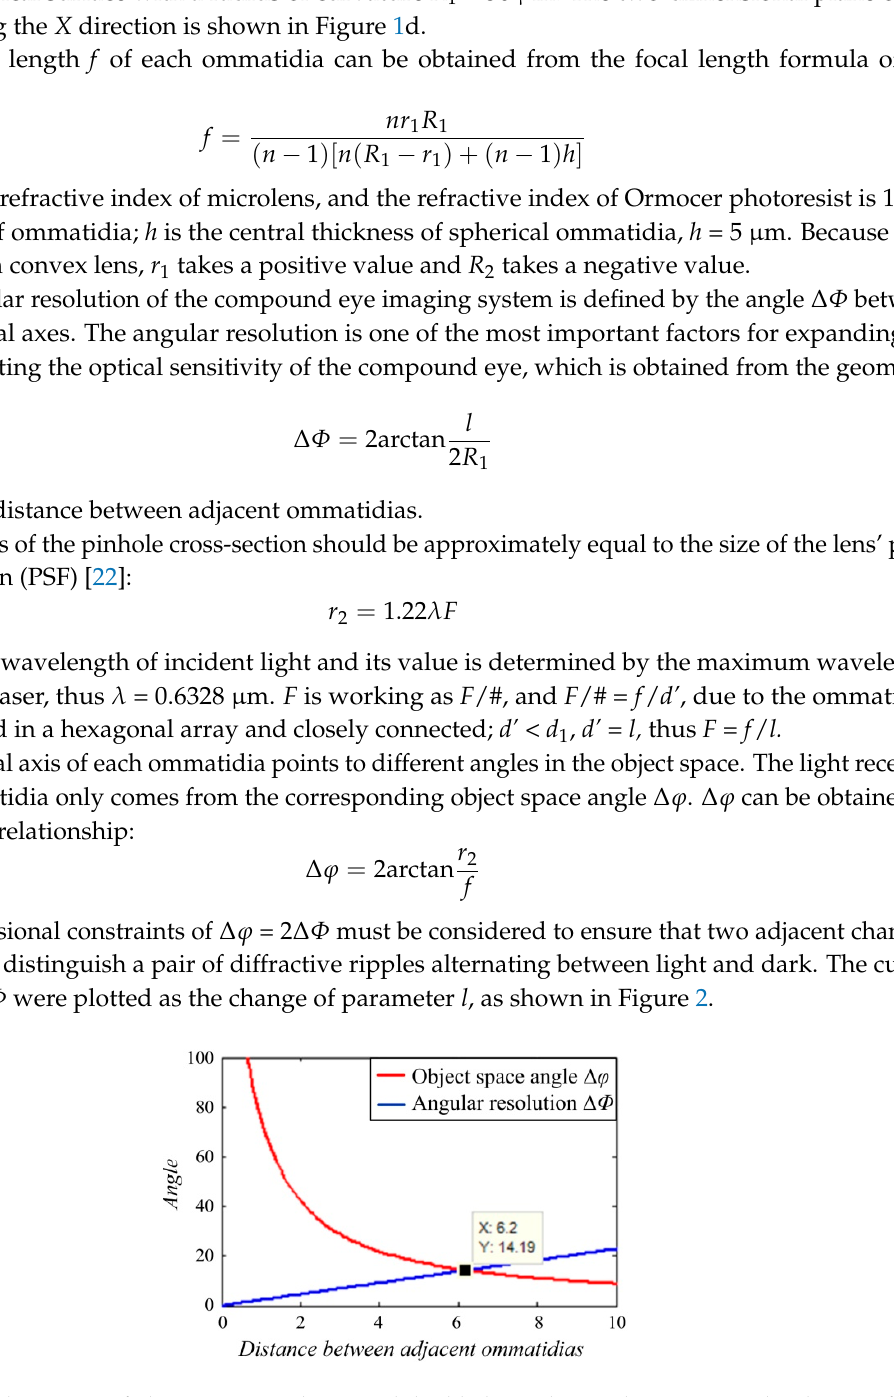
Figure 2. The curves of object space angle Δ φ and doubled angular resolution Δ Φ as the change of distance l between adjacent ommatidias.